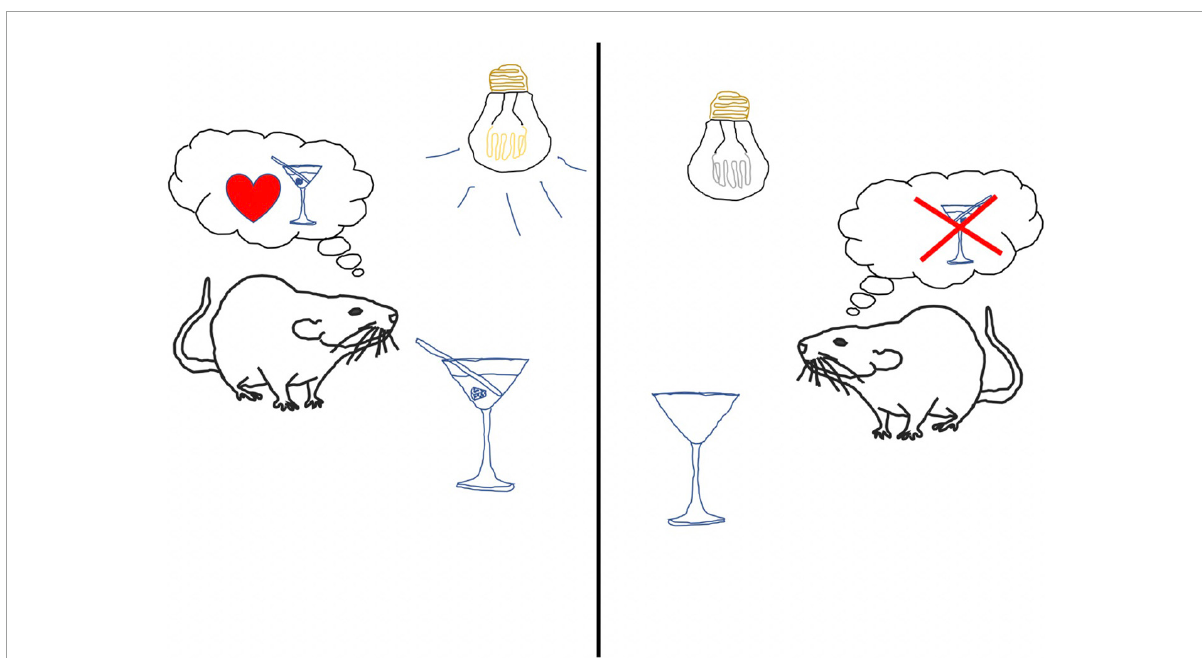
FIGURE3 Summary of study characterizing conditioned alcohol cue reactivity. Rats were conditioned to light cues paired with alcohol. We analyzed sipper approach by scoring the rats’ sipper approach behavior before houselight illumination and during the illumination. We also analyzed the latency for the rats to start licking the sipper, and the lick rate across the sipper access window. We found that houselight illumination triggered conditioned approach to the sipper access site. We also found that sipper presentation elicited licking, even when no alcohol was present in the sipper and in the absence of alcohol odor in the air. We also found a strong increase in lick rate upon initial receipt of alcohol from the sipper, suggesting that receiving oral alcohol may, in and of itself, act as a cue that stimulates consummatory behavior (drinking). In additional analyses, we found rats with the greatest conditioned approach reactivity to the most distal alcohol cue (i.e., houselight illumination) also were the fastest to initiate drinking, and drank the